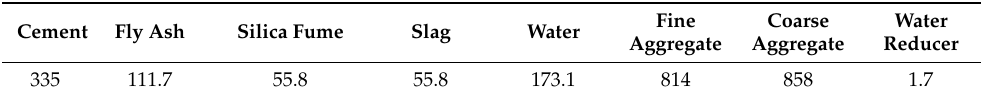
Table 6. Mix proportion of C40 SCC (kg/m 3 ).